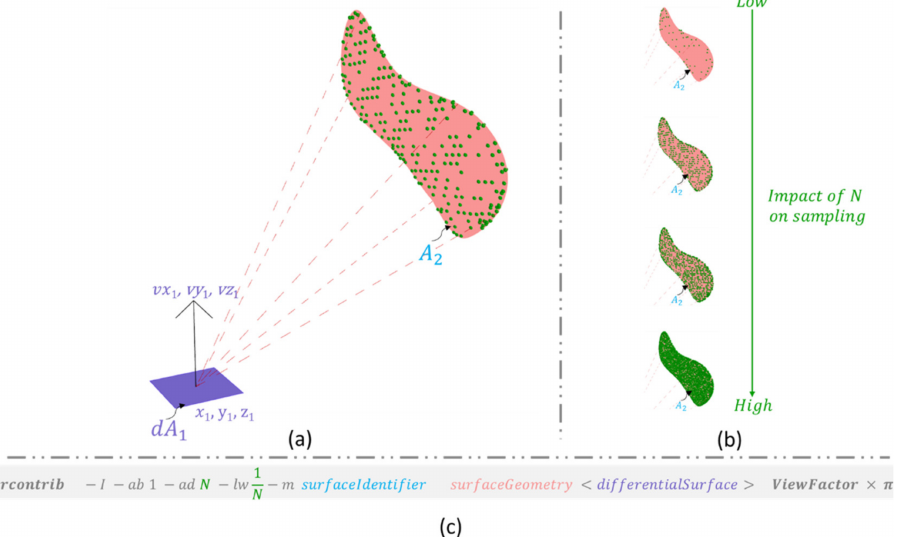
Figure 3. Calculation of view factor between a differential surface and a finite surface with rcontrib . The dots on the finite surface in ( a ) indicate the sampling controlled by the -ad parameter. As shown by ( b ), increased sampling will improve the estimation of the view factor. An explanation of the terms in the syntax ( c ) is provided in the